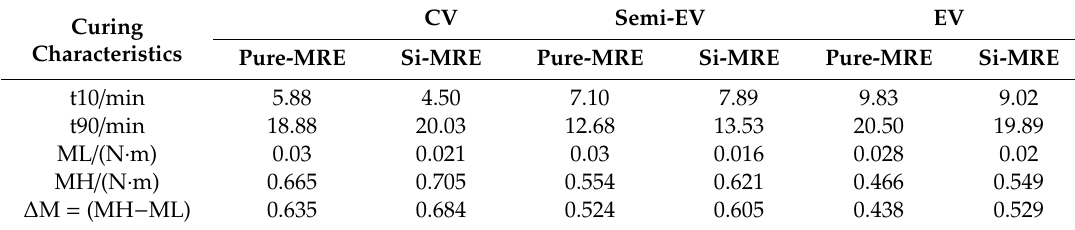
Table 2. The curing characteristics of pure-MRE and Si-MRE with di ff erent curing systems.